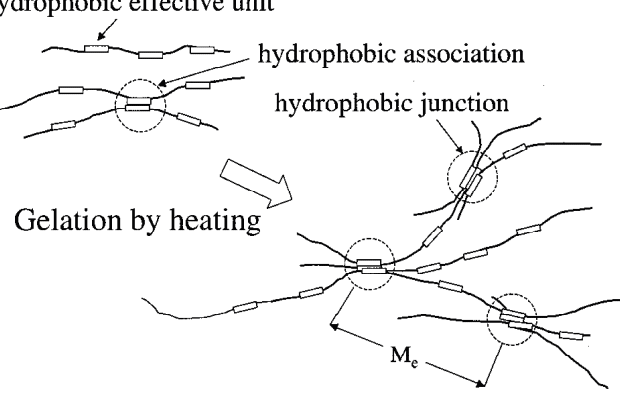
Figure 9. Schematic drawing showing gelation through the hydrophobic effective units of methylcellulose. At lower temperatures, the hydrophobic association is possible from the hydrophobic effective units. During heating, the gel is formed with the hydrophobic junctions consisting of such hydrophobic effective units and the mean length M e between two junctions remains constant when the gelling temperatures are higher than 42.5